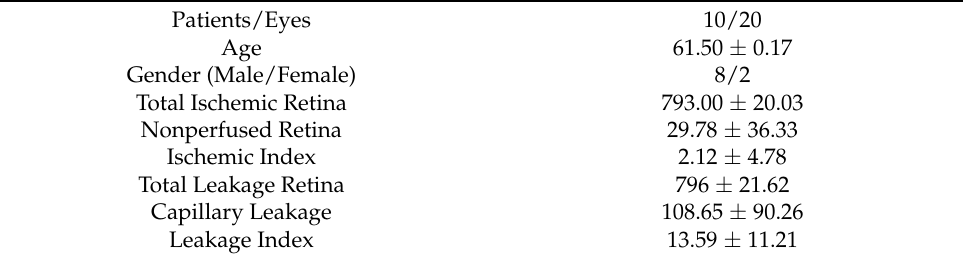
Table 1. Patient demographics and main clinical